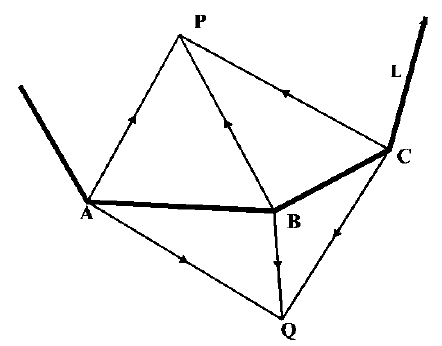
Figure 3. Judging the position of Point P , Q relative to the curve L .